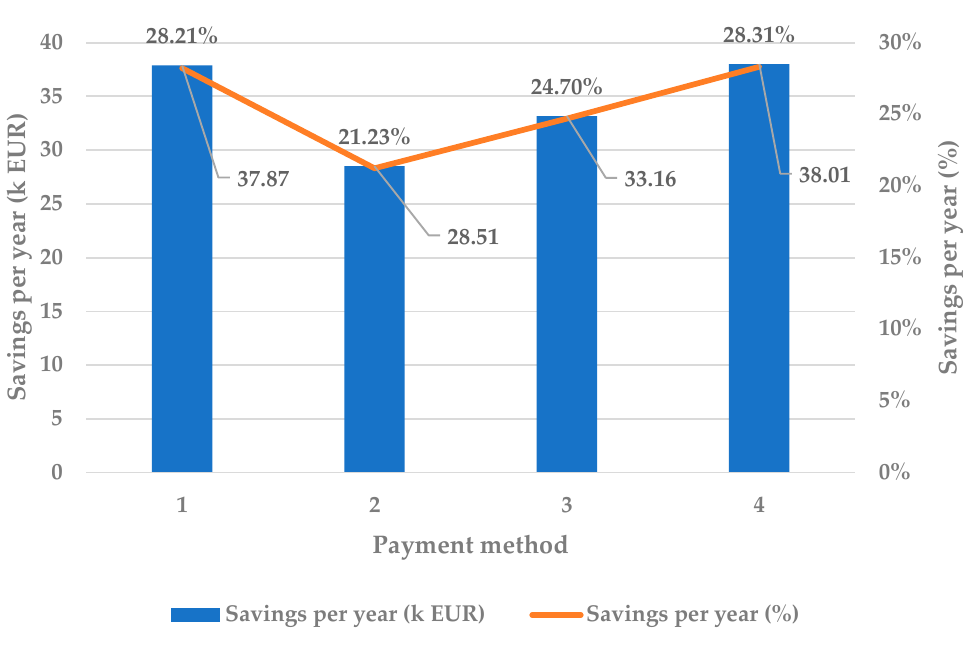
Figure 9. Savings per year for different prosumer payment methods.